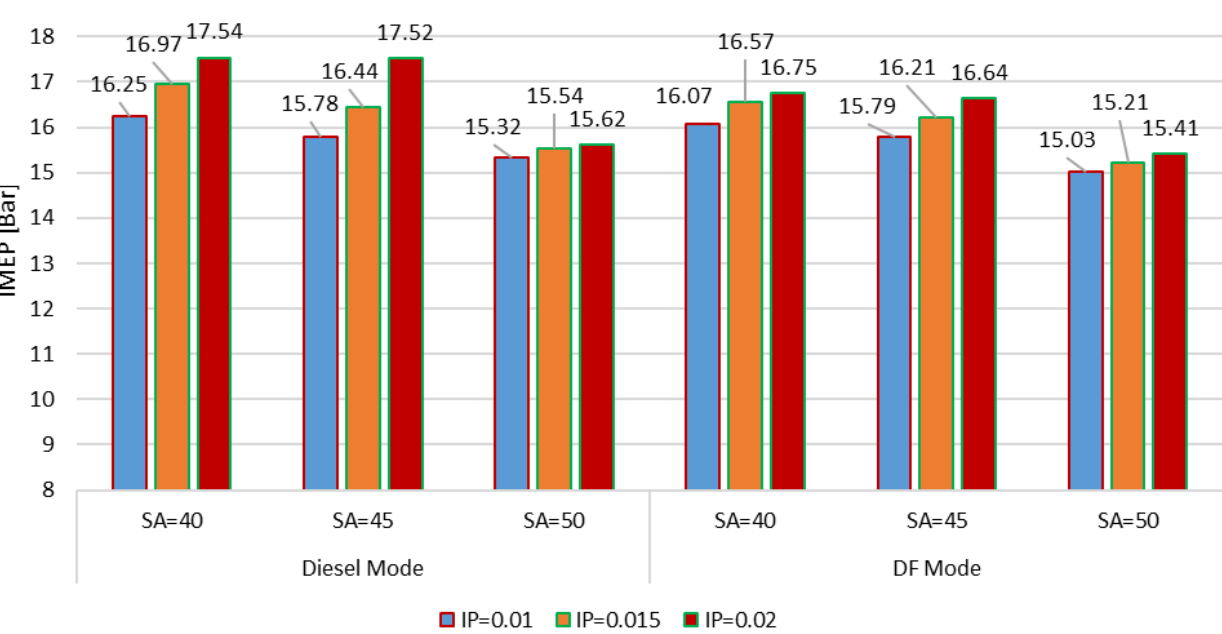
Figure 10. IMEPs of the engine in all simulation cases.